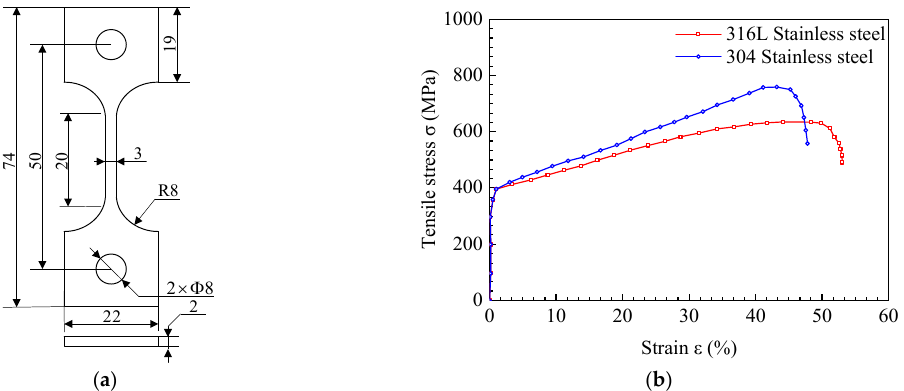
Figure 2. Stress–strain tensile test. ( a ) Tensile test size, and ( b ) stress–strain curve of 304 and 316 L stainless ‐ steel. Table 1. Material ultimate strength of welded joint finite element model.